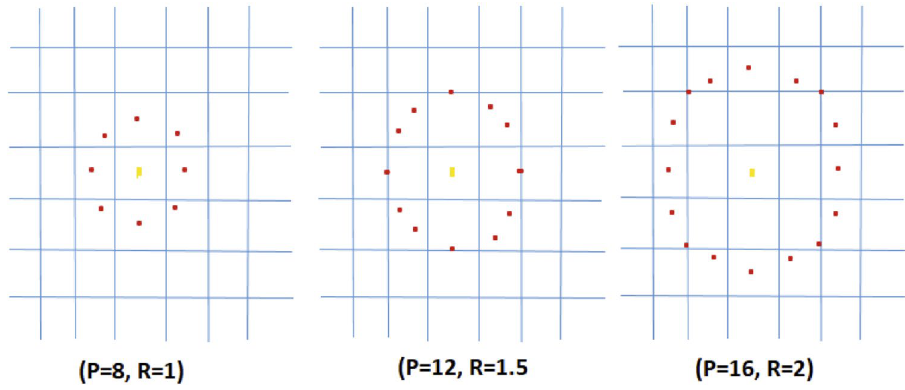
Figure 6. Three examples of the extended LBP which makes it ideal for real-time